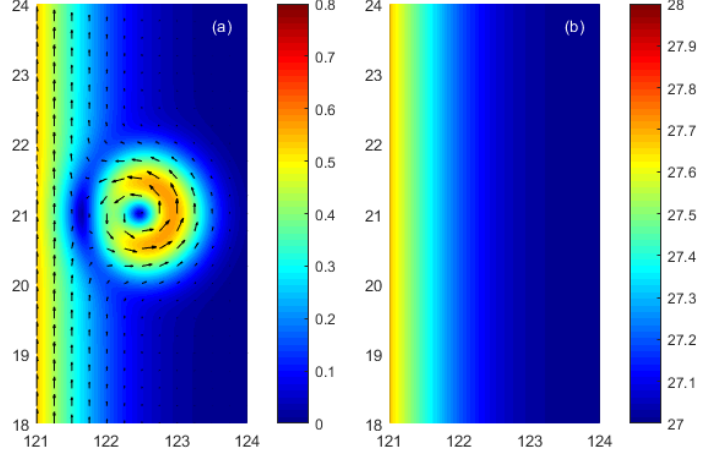
Figure 10. ( a ) Velocity field (vectors) for the ideal experiment. Color: speed (ms − 1 ). ( b ) Initial temperature distribution ( ◦